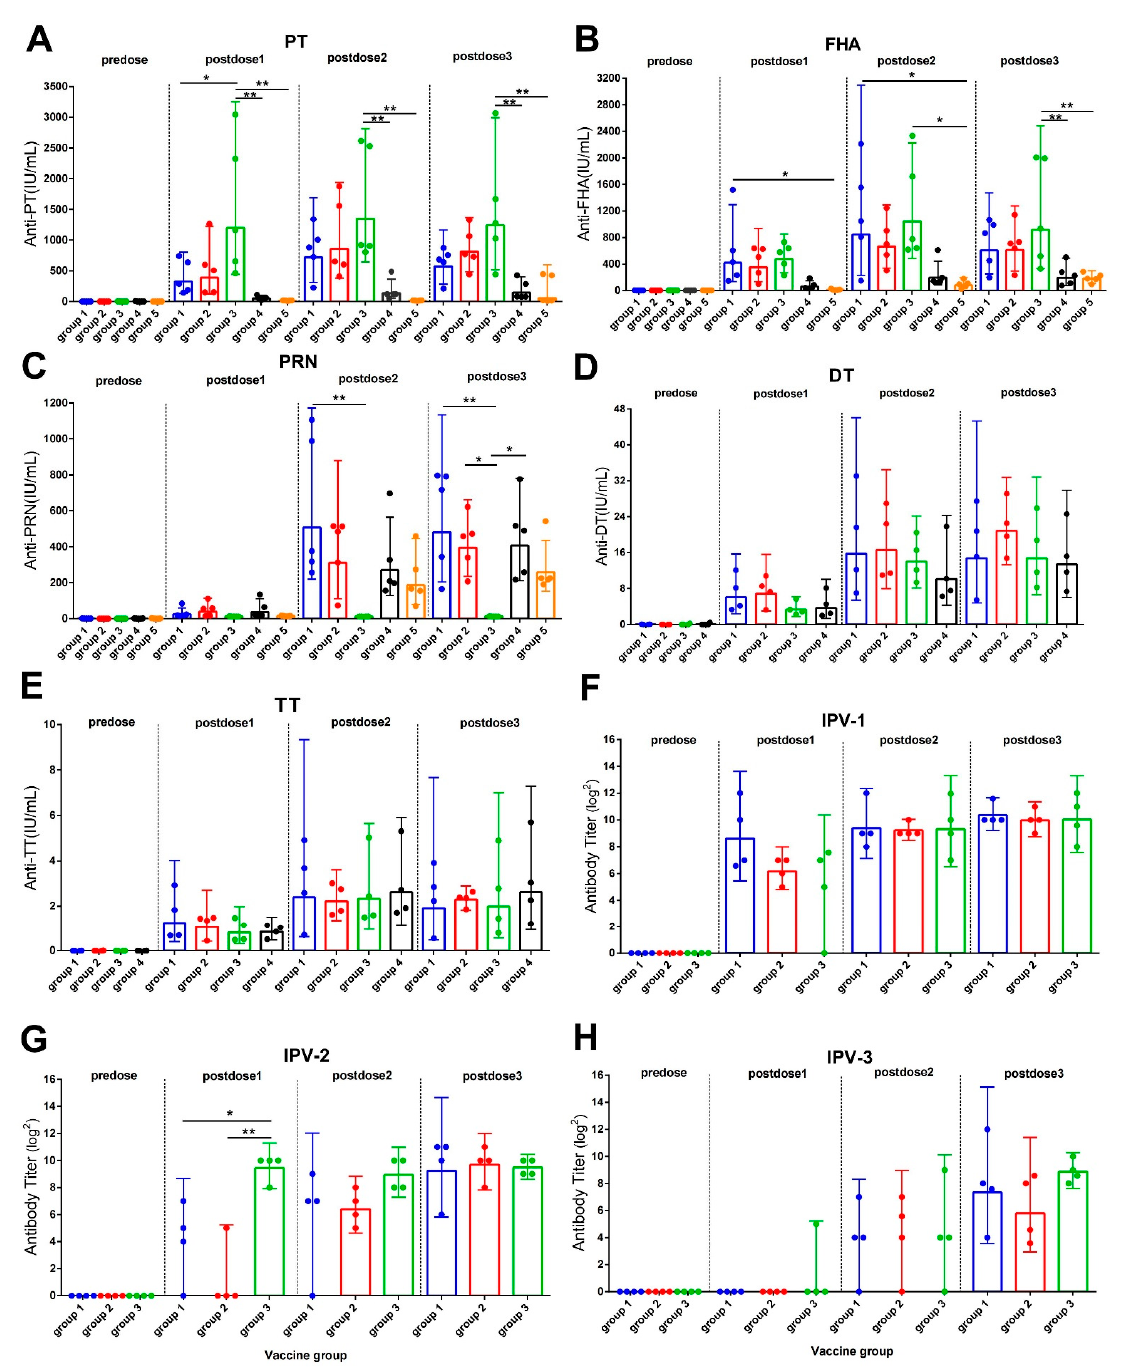
Figure 2. Antibody levels in the rhesus macaques from different groups after immunization with vaccines. ( A – E ): Anti-PT, anti-PRN, anti-FHA, anti-DT, and anti-TT antibodies tested using ELISA. Standard serum was prepared using International Standard for Pertussis Antiserum (Human Re- source) (NIBSC Code: 06/140, provided by NIFDC), National Standard for Tetanus Human Im- munoglobulin (Batch No. 001, Specification: 10 U/vial, provided by NIFDC), and International Standard for Diphtheria Human Antibody (Batch No. 10/262, Specification: 2 U/vial, provided by NIBSC). ( F – H) : Type I, II, and III polio antibodies tested using neutralization method with Hep-2 cells. The results of the negative control (group 6) were below the detection limit and hence not shown in the figure. Data were analyzed using one-way ANOVA with Tukey’s multiple comparison test. * p < 0.05, ** p < 0.01 ( n =